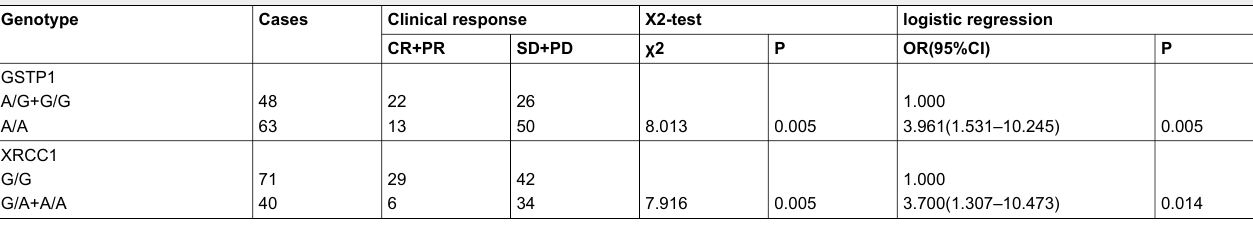
Table 3: The combination of GSTP1 and XRCC1 polymorphisms and chemotherapy response (n = 111).